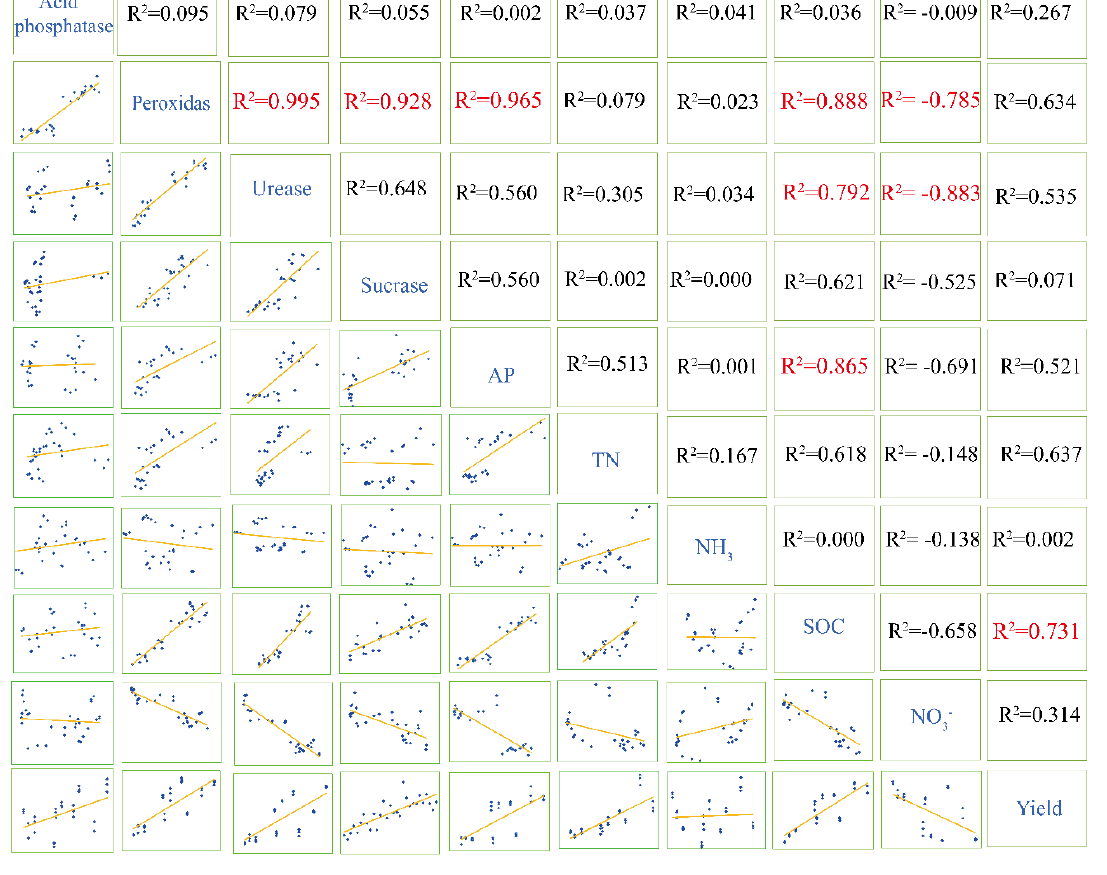
Figure 4. The linear correlation analysis among various parameters containing enzyme activities, physiochemical characteristics, and yields; * means the correlation is significant at the 0.05 level, and ** indicates that correlation is significant at the 0.01 level. indicates that correlation is significant at the 0.01